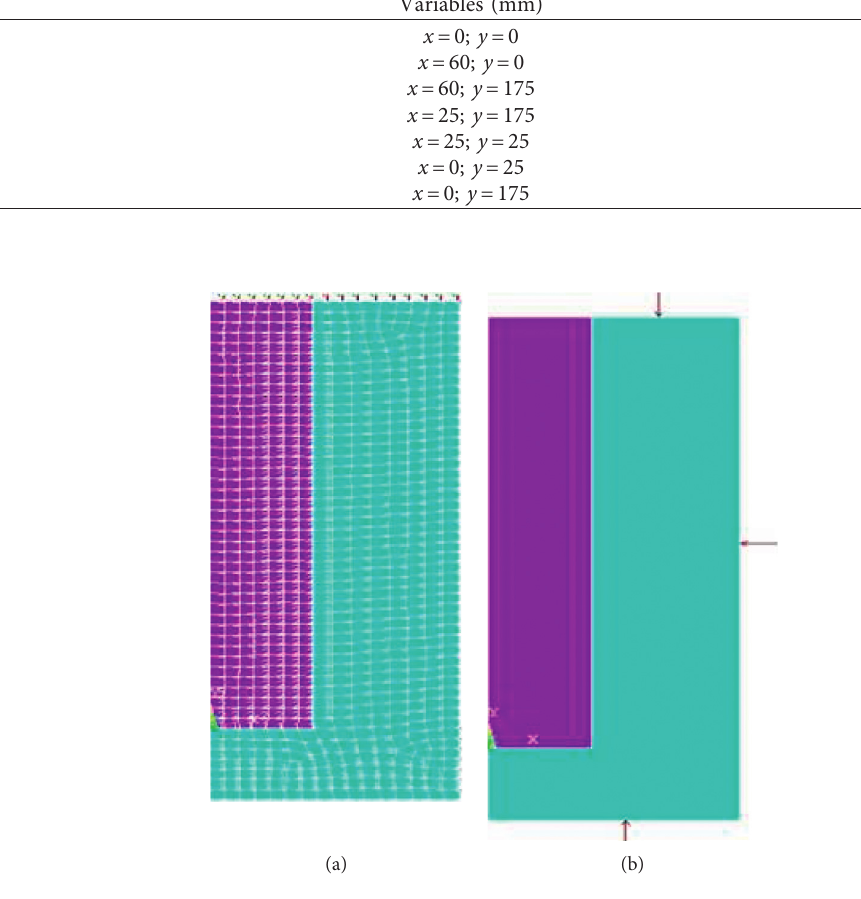
Figure 2: (a) FEA model of melt and die without BCs. (b) Convection boundary conditions of the FEA